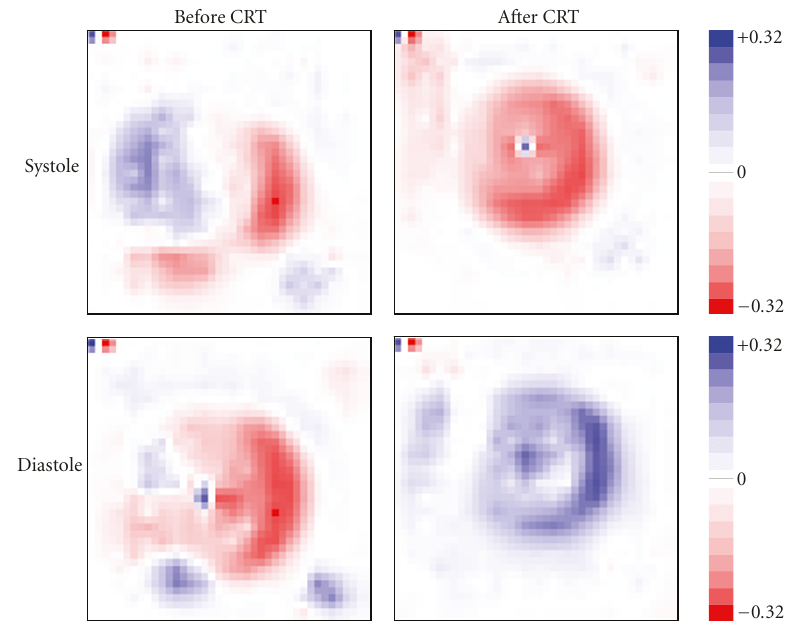
Figure 7: Vertical rotation in a Group1 patient. Middle slices shown during systole and diastole before and after CRT. The pattern is similar to the normal pattern before and after CRT as well as in systole and diastole. The color scale is shown at the top right of the